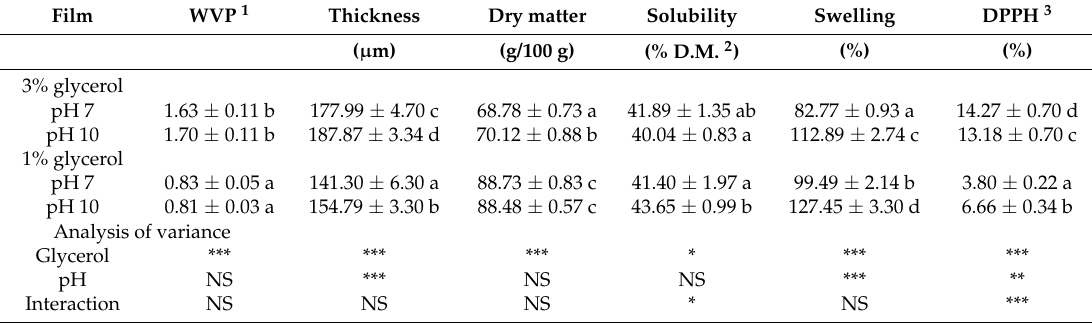
Table 1. Water vapor permeability, thickness, dry matter, solubility, swelling and DPPH radical scavenging capacity of